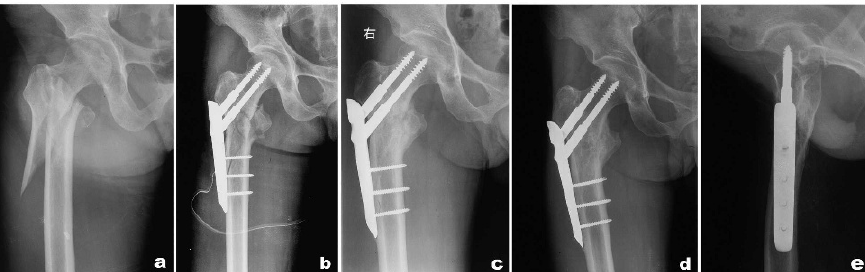
Figure 5 - The initial and follow-up radiographs of a sample case. A) Initial radiograph. B) Radiograph 1 day postoperatively. C) Anteroposterior radiograph at 10 months postoperatively demonstrating the fracture healing. D, E) Anteroposterior and lateral